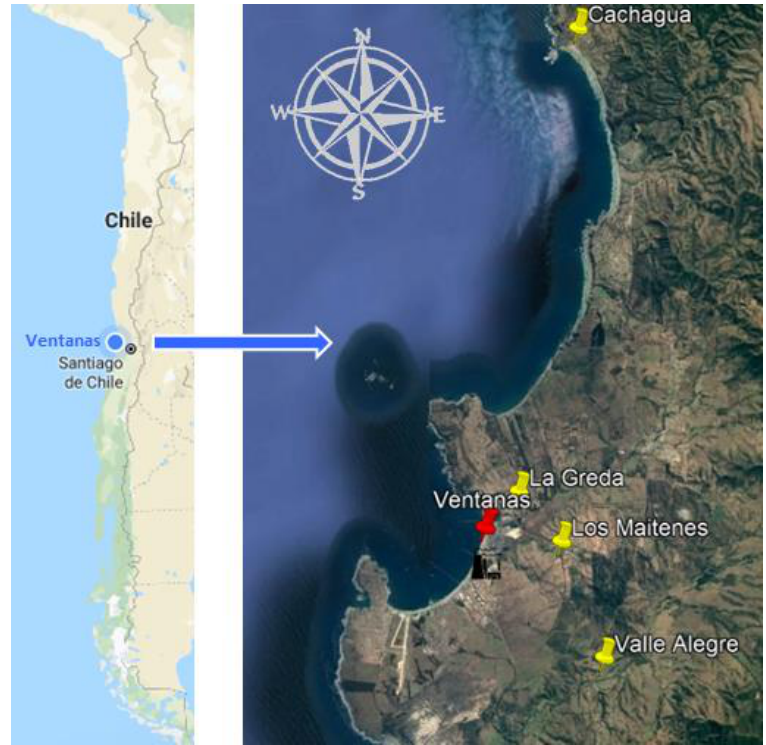
Figure 1. Geographical locations of the monitoring sites according to GPS